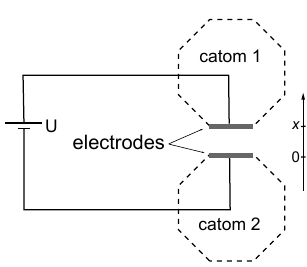
Figure 3. Principle of electrostatic actuator based on parallel capacitors.